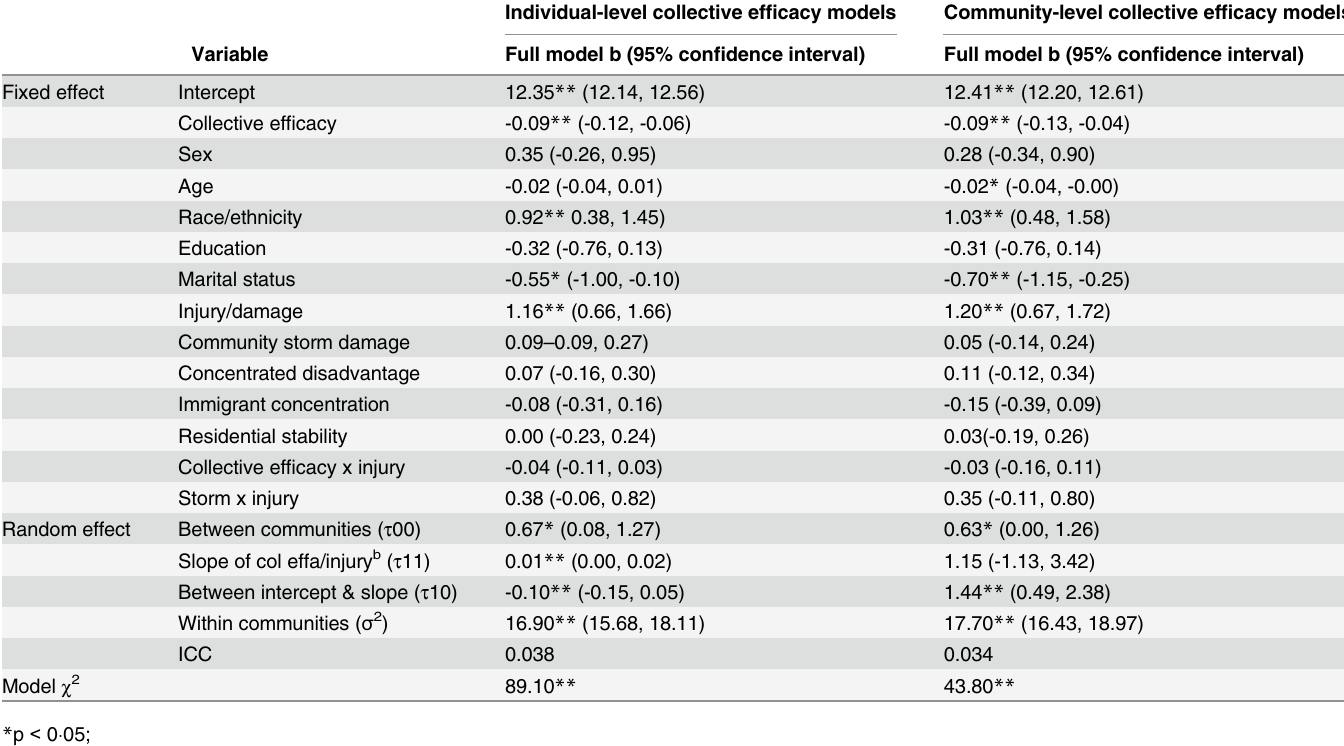
Table 2. Parameter estimates of two multilevel linear regression models on Depressive Symptom Severity (n =